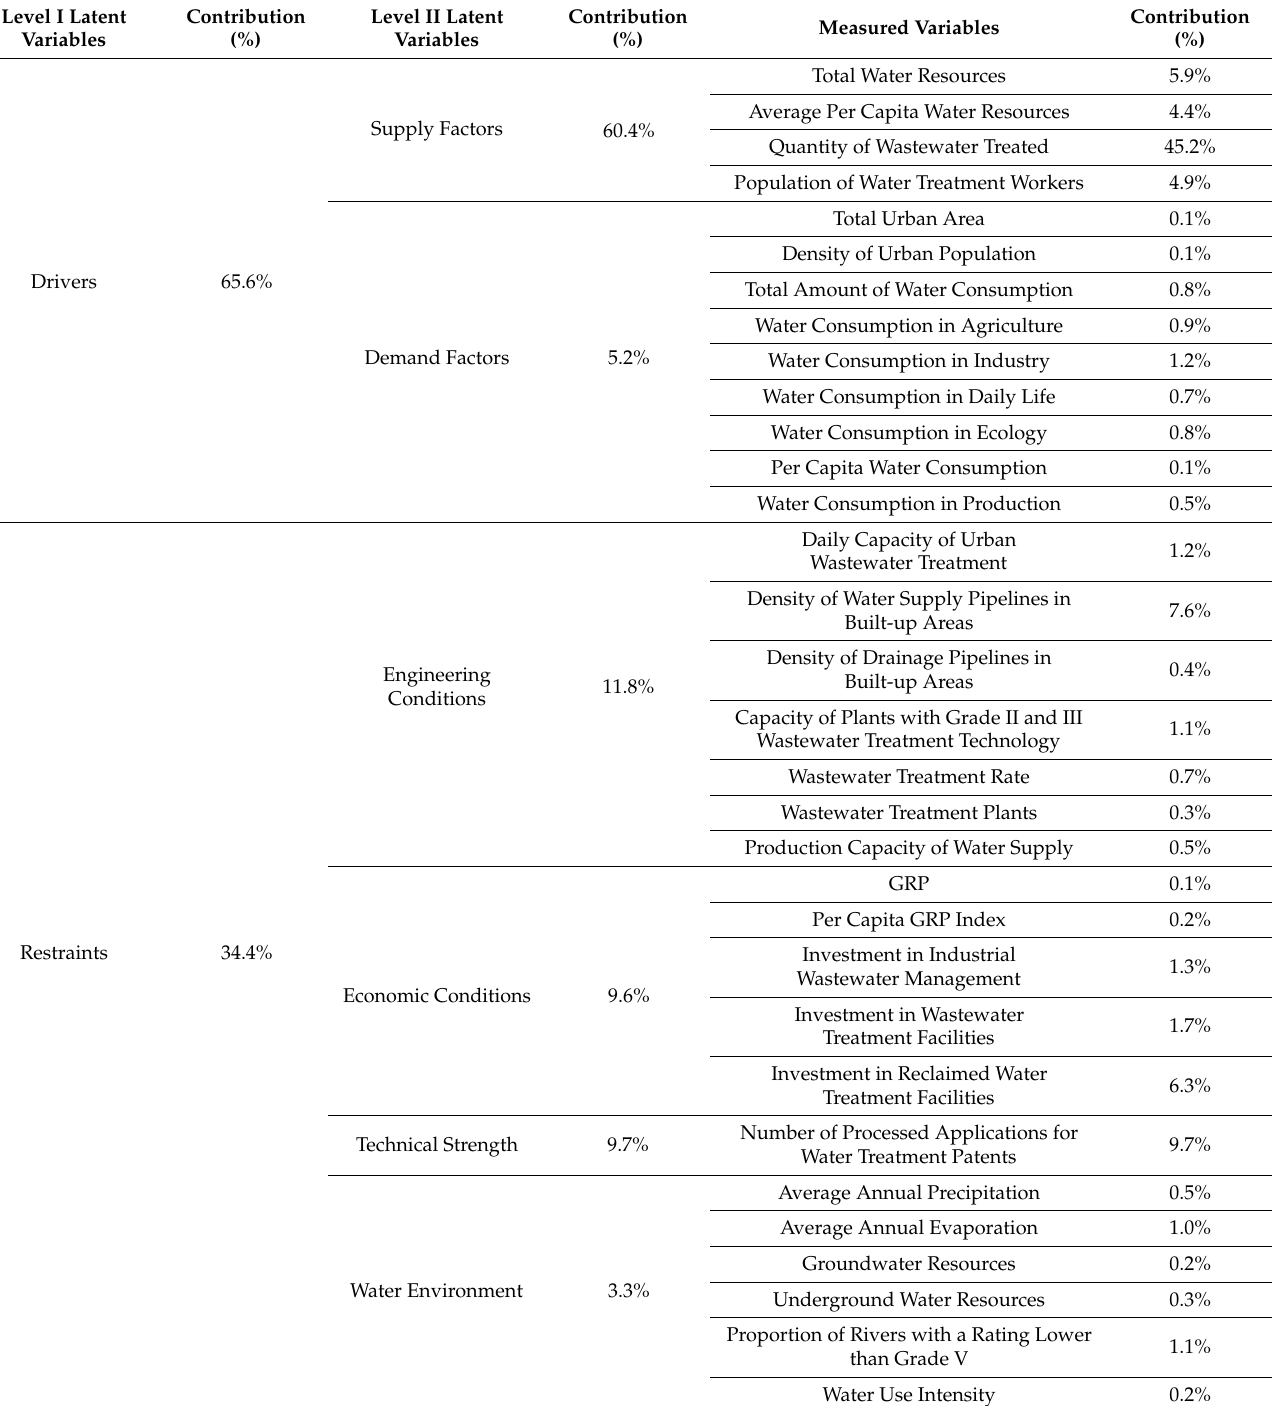
Table 4. Contribution of each latent and measured variable to the impacts on reclaimed water